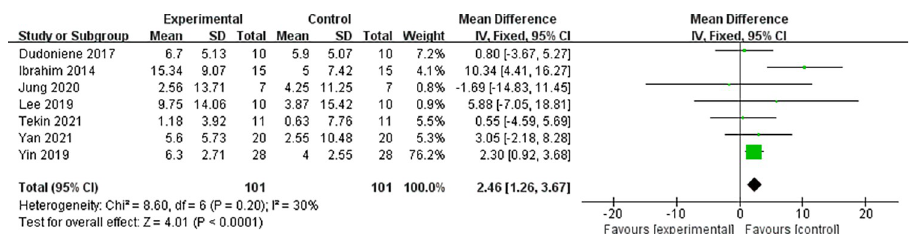
Fig 4. Effect of WBV training on GMFM88-D score in children with cerebral palsy.